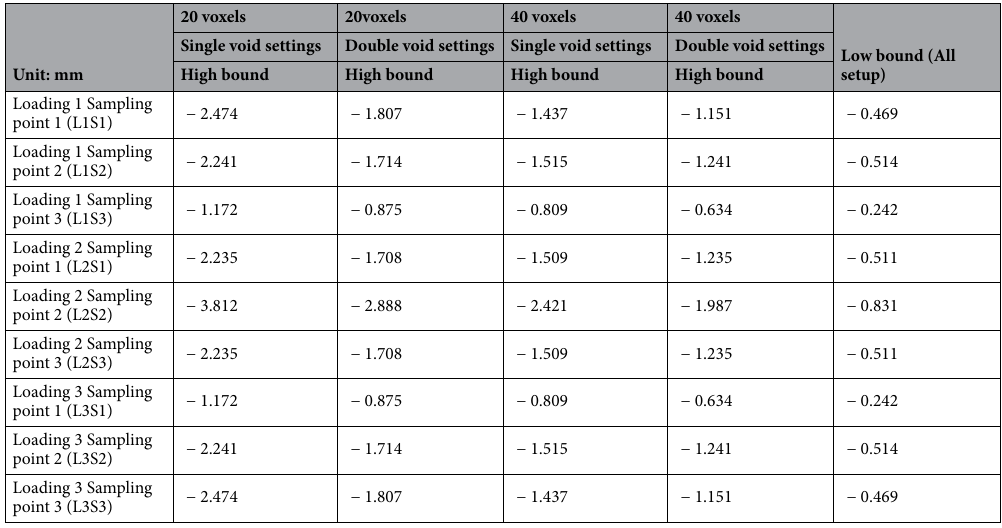
Table 3. The limiting ranges of beam deflections at the sampling points resulting from the voxel geometrical parameters calculated via FEM simulation by COMSOL Multiphysics as listed in Table 2.